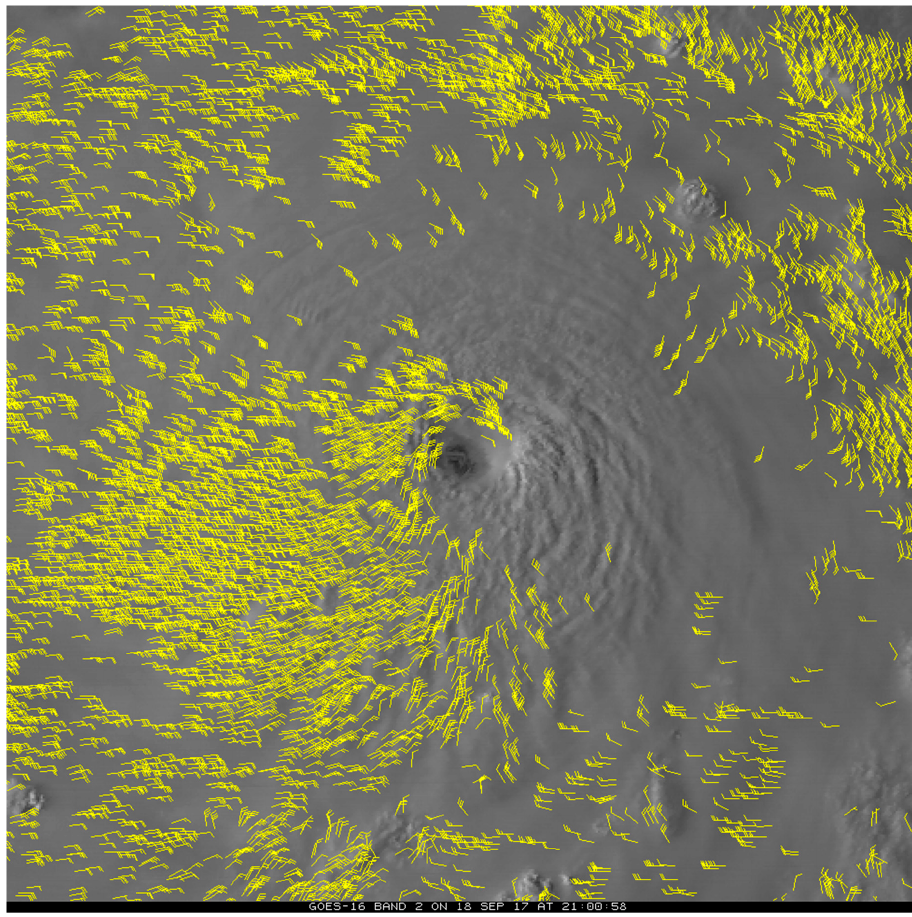
. Figure 5. VIS AMVs generated for the same date / time as Figure 2 using all of the above modifications Figure 5. VIS AMVs generated for the same date/time as Figure 2 using all of the above modifications for hurricane-scale processing. Plotted AMVs are limited to QI ≥ 90 and cloud top temperatures for hurricane-scale processing. Plotted AMVs are limited to QI >= 90 and cloud top temperatures <= ≤ 220 K. Remote Sens. 2019 , 11 , x FOR PEER REVIEW 220 K.